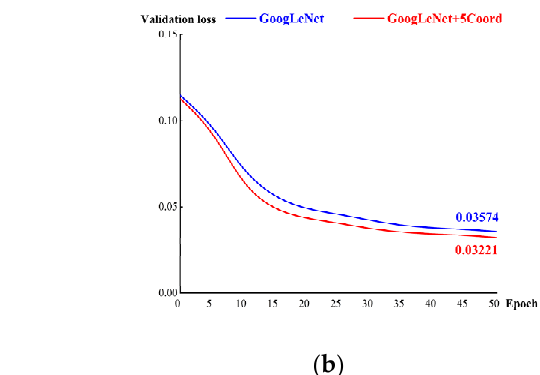
Figure 7. Accuracy and loss of the validation dataset when applying two algorithms: ( a ) validation accuracy; ( b ) validation loss.